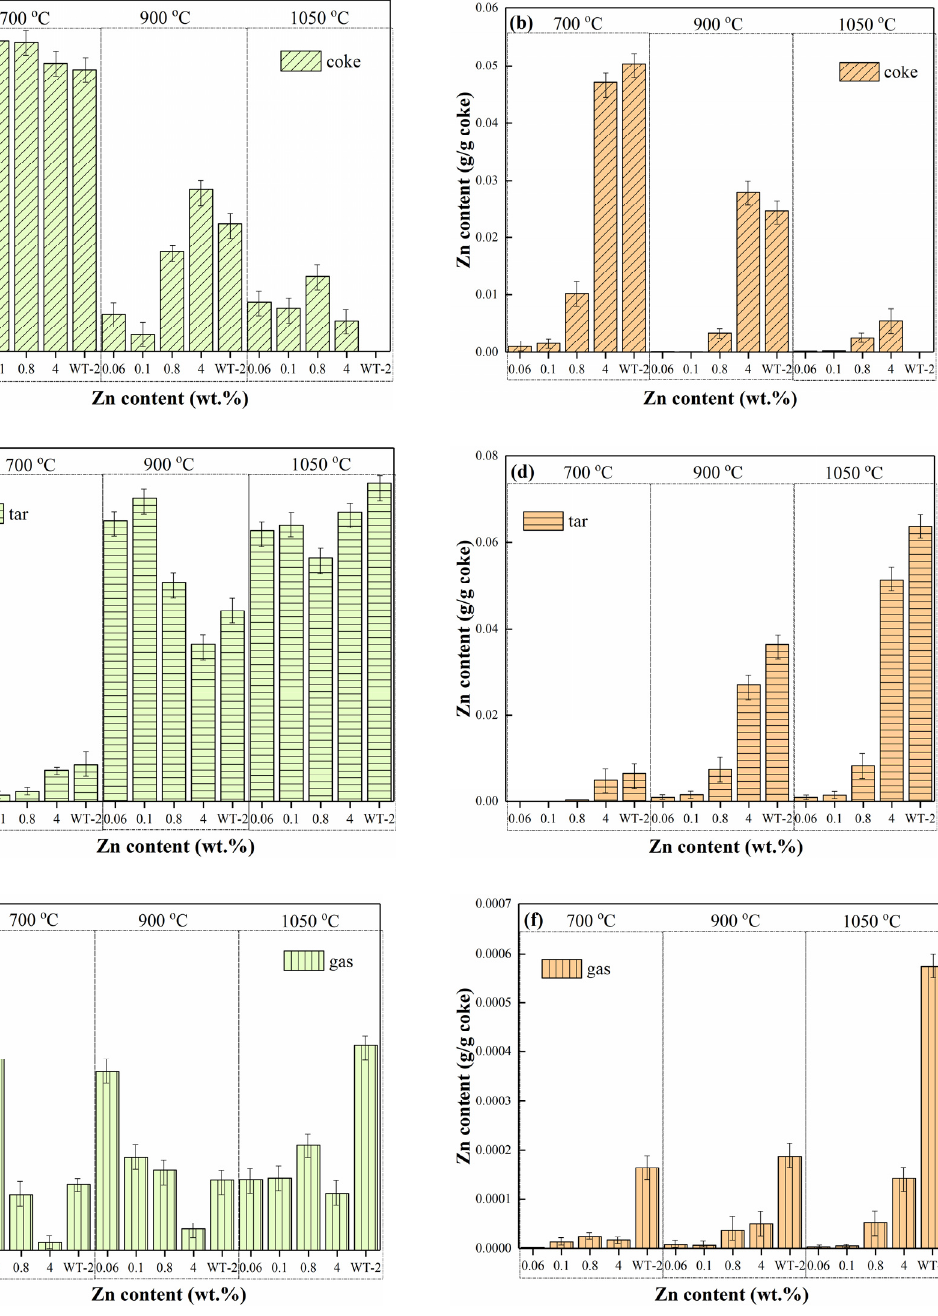
Figure 6. The relative percentages (%) ( a , c , e ) and contents (g/g coke) ( b , d , f ) of Zn in the coke, tar and gas under different pyrolysis conditions.